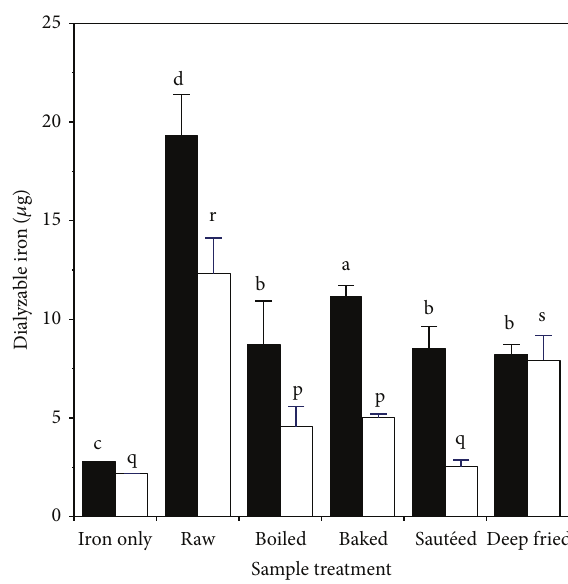
Figure 2: Effect of heating on production of dialyzable iron during digestion of chicken muscle: ◼ total dialyzable iron; ◻ ferrous dialyzable iron. Values are the mean ± standard deviation ( 𝑛 = 10 ). Means in the same group ( ◼ or ◻ ) without a common letter differ at 𝑃 < 0.05